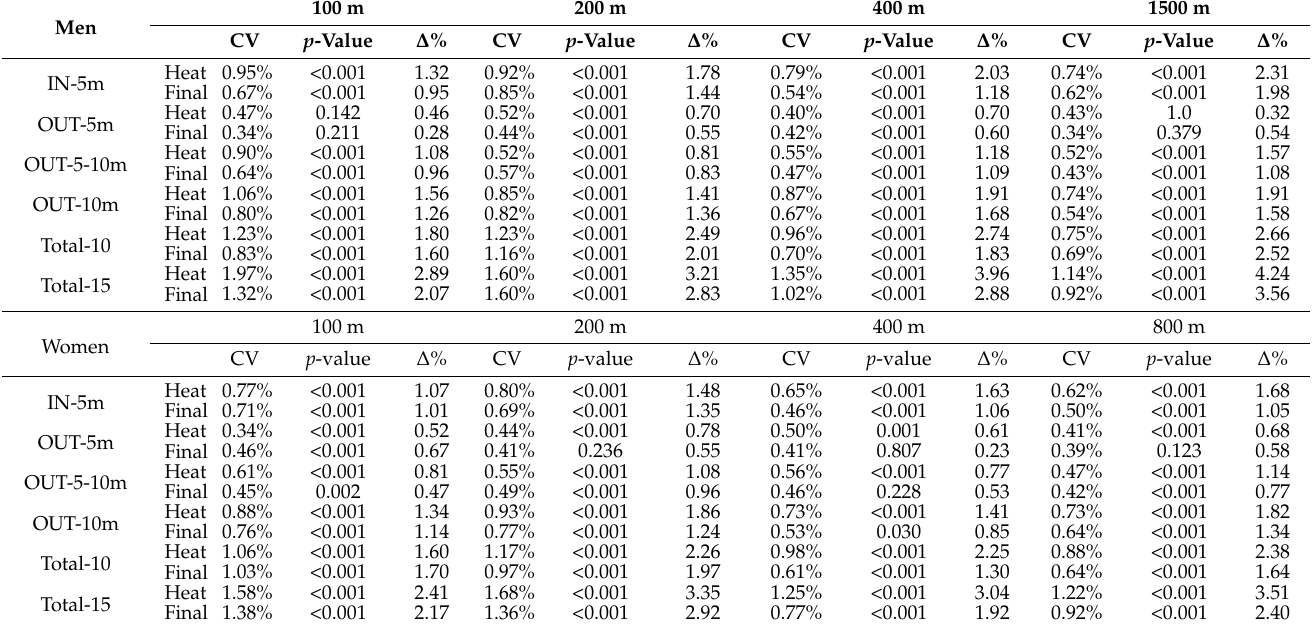
Table 1. Intra-individual coefficients of variation (CVs) and relative changes in performance ( ∆ %) compared with the linear mixed-effect model analysis. CV and ∆ % were determined based on 3, 7, 15, 31, and 59 turns for the 100 m, 200 m, 400 m, 800 m, and 1500 m events, respectively. The eight finalists were compared with the eight fastest but non-qualified swimmers from the heats for each